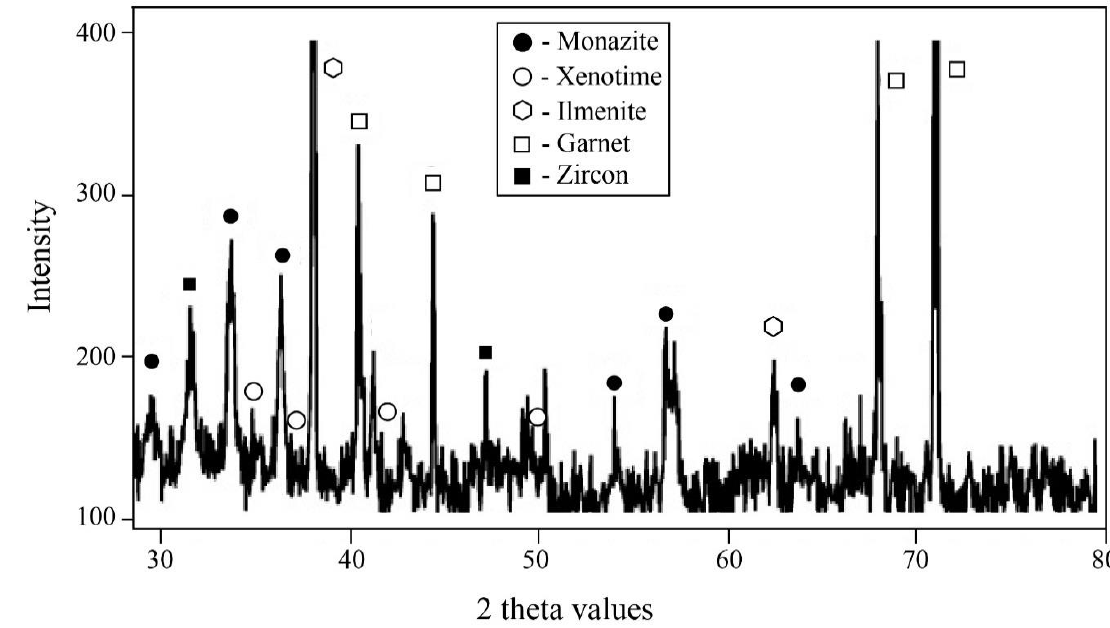
Figure 7. Concentrate’s XRD patterns indicating REE-bearing and other heavy minerals.